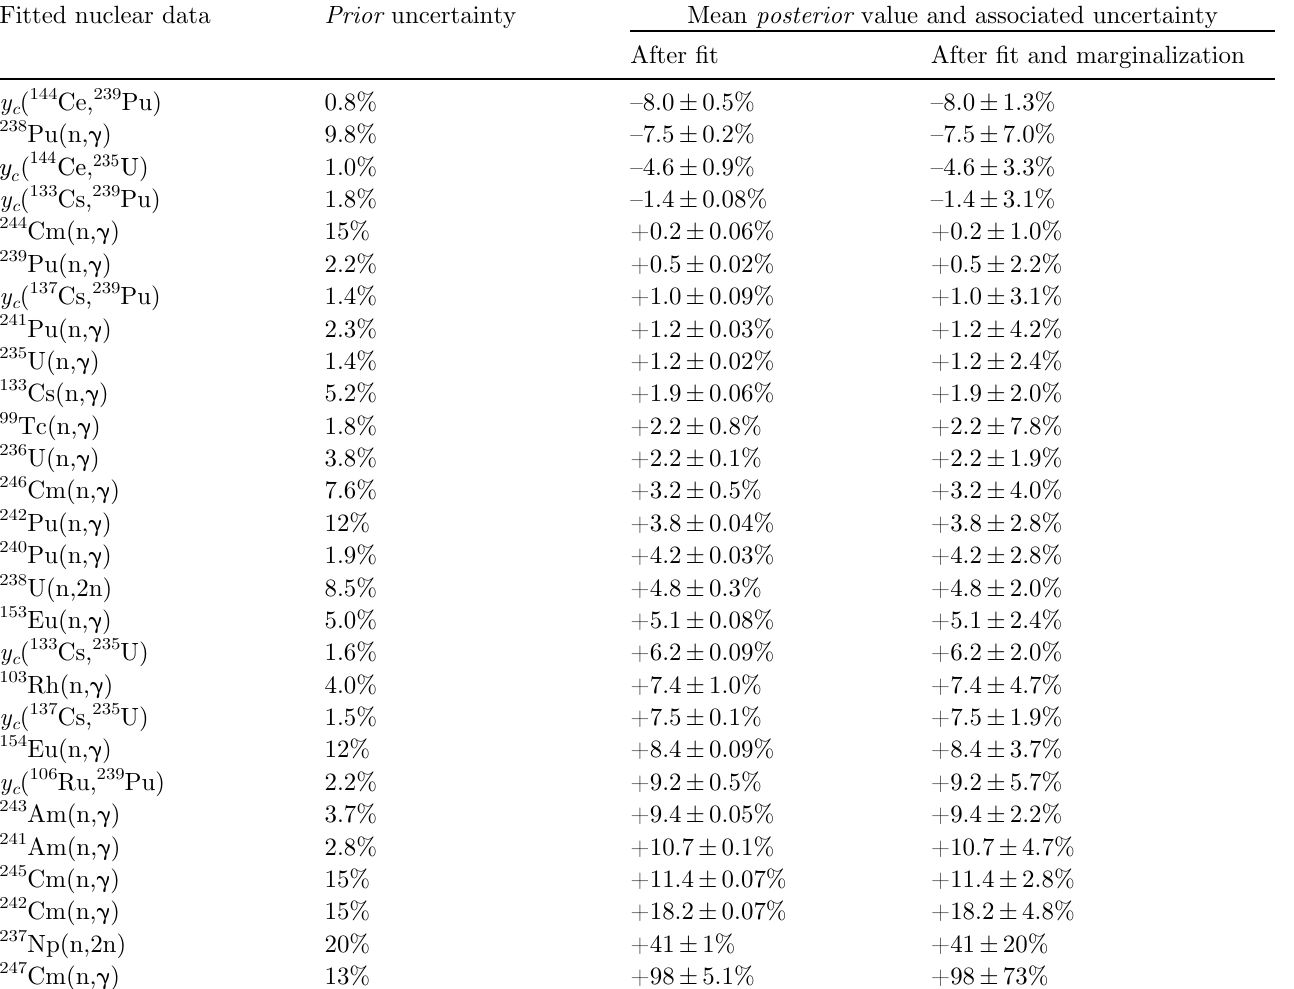
Table 4. Nuclear data adjustment trends obtained from the Integral Data Assimilation of the C/E-1 values reported in reference